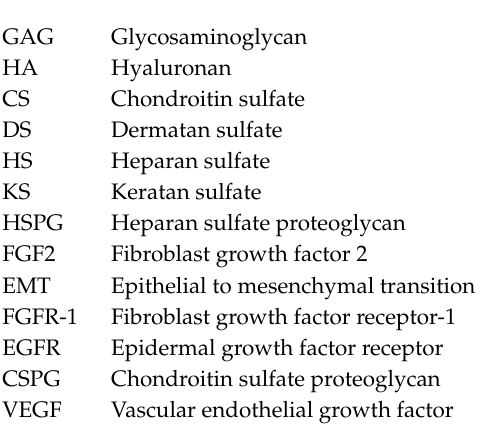
Figure 7. Chemical structure of CDSO 3 , n = 5–13.